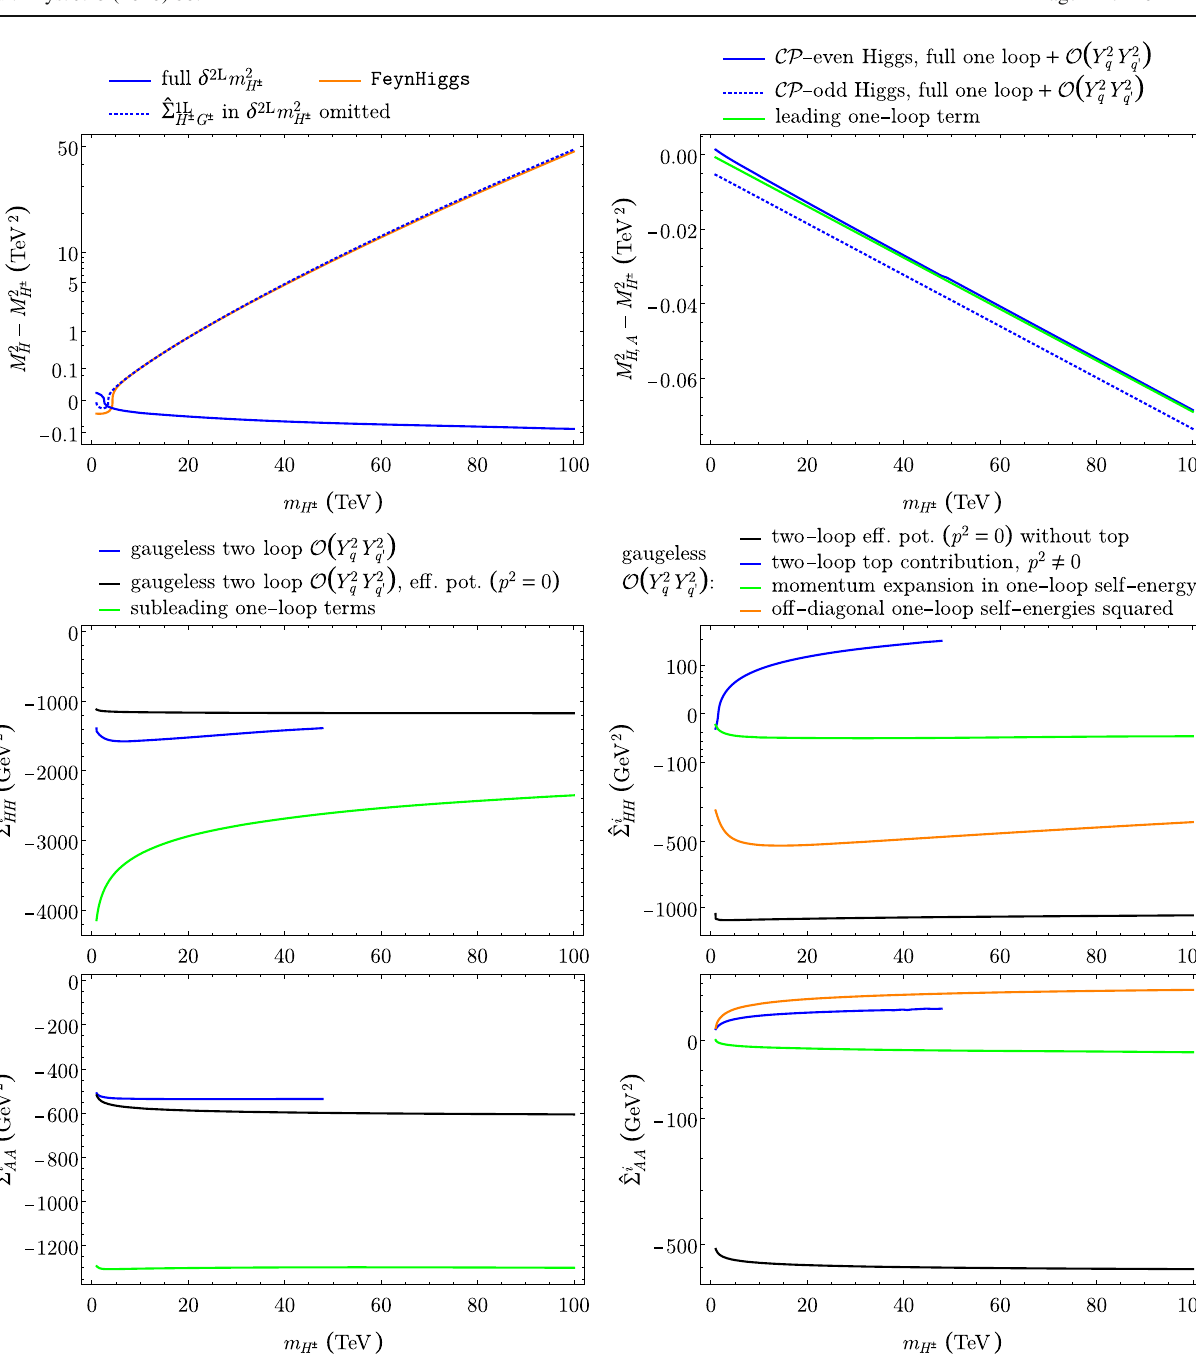
loop term from gauge corrections; subleading one-loop contributions in green; two-loop O ( Y 4 q ) contributions in the effective potential approxi- mation (black), and in the gaugeless limit (blue); Middle right: Contri- butions of order O ( Y 4 q ) to the CP -even self-energy; SUSY and bottom (black), and top (blue) diagonal two-loop pieces; diagonal one-loop squared piece (green); off-diagonal one-loop squared piece (orange); Bottom left and right: As middle left and right but applied to the CP - odd state. The two-loop contribution to the diagonal self-energy in the gaugeless limit is only displayed up to 50TeV in order to avoid numer- ical